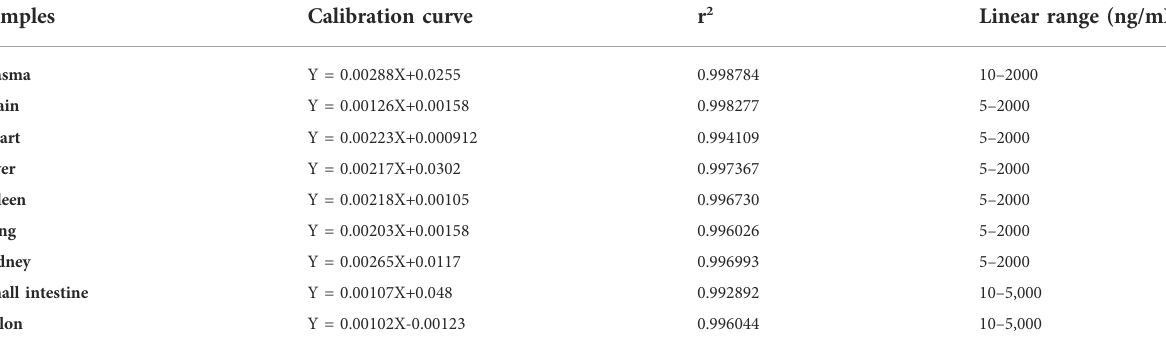
TABLE 1 Calibration curves, correlation coef fi cients (r 2 ), and linear ranges of curcumol in rat plasma and tissue homogenates. Samples Calibration curve r 2 Linear range (ng/mL) Plasma Y =